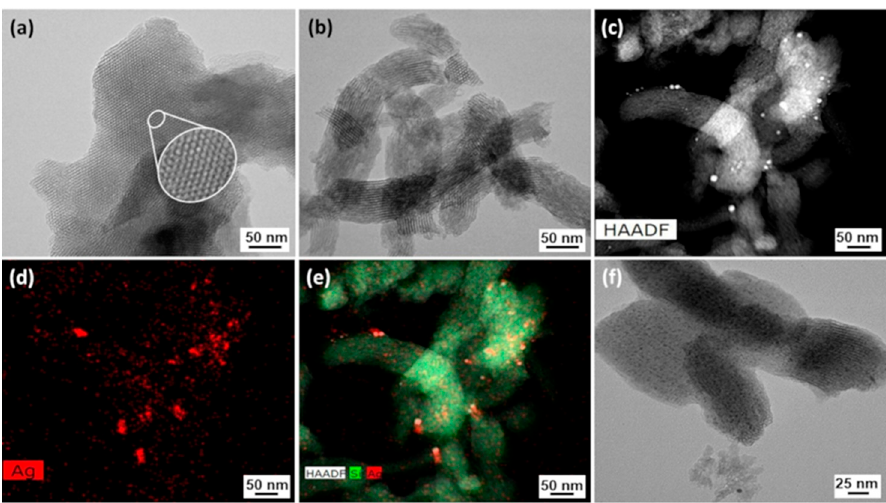
Figure 2. ( a , b ) HRTEM micrograph for pure MCM-41 M ; ( c ) STEM, ( d ) EDX, ( e ) STEM-EDX and ( f ) HRTEM analysis for AgNO 3 / MCM-41 M .